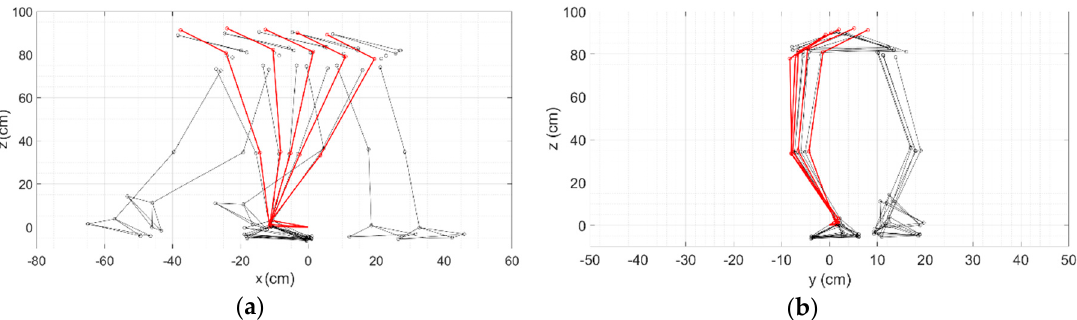
Figure 4. Lower body reconstruction through the camera-based system (black structure) with an overlapping leg reconstruction from the MIMUs (red structure): ( a ) lateral view, and ( b ) frontal view.